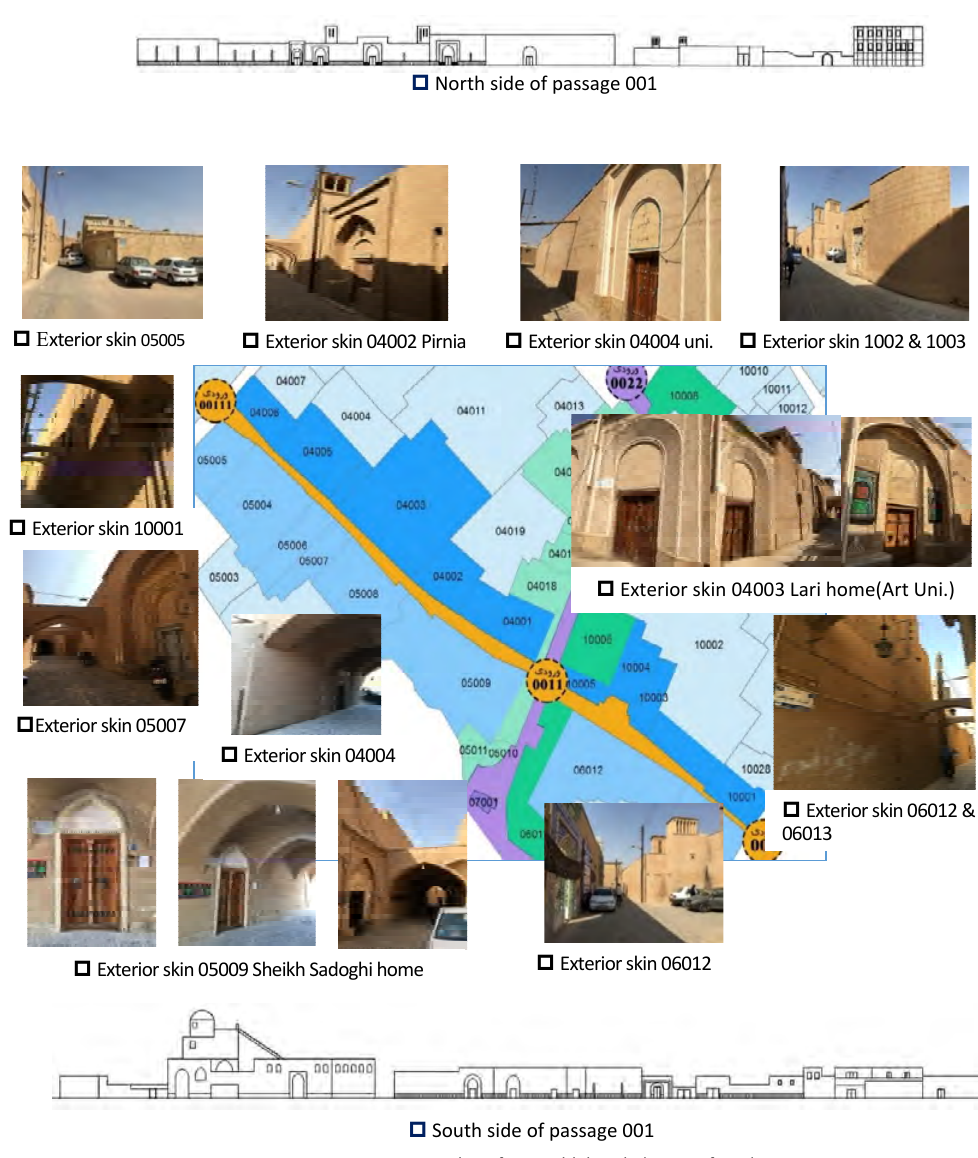
Fig. 8: Passage exterior skin of 001 Sahl Ibn Ali district of Yazd